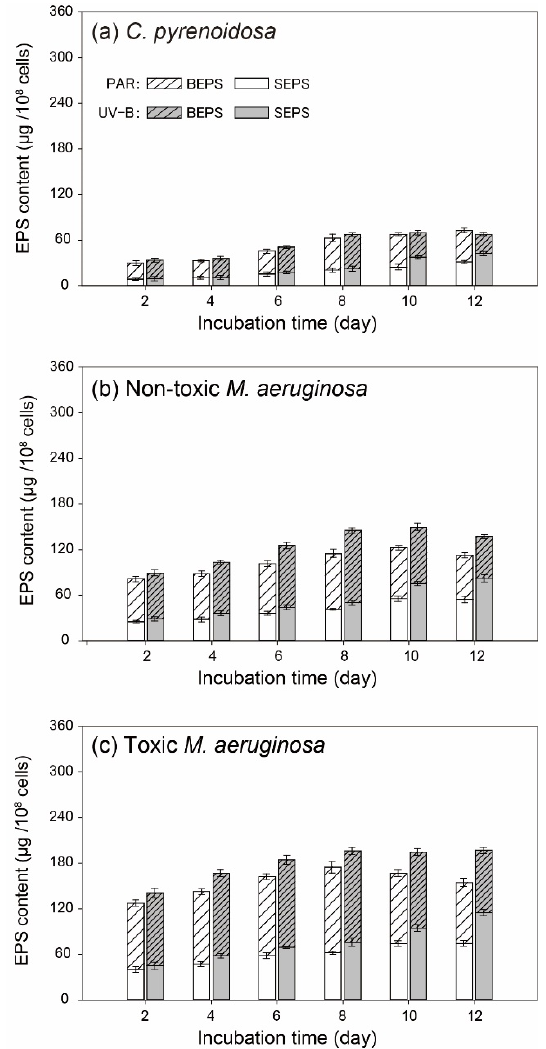
Figure 5. Contents of BEPS and SEPS produced by (a) C. pyrenoidosa , (b) non ‐ toxic M. aeruginosa and (c) toxic M. aeruginosa cells in the PAR and UV ‐ B treatments.